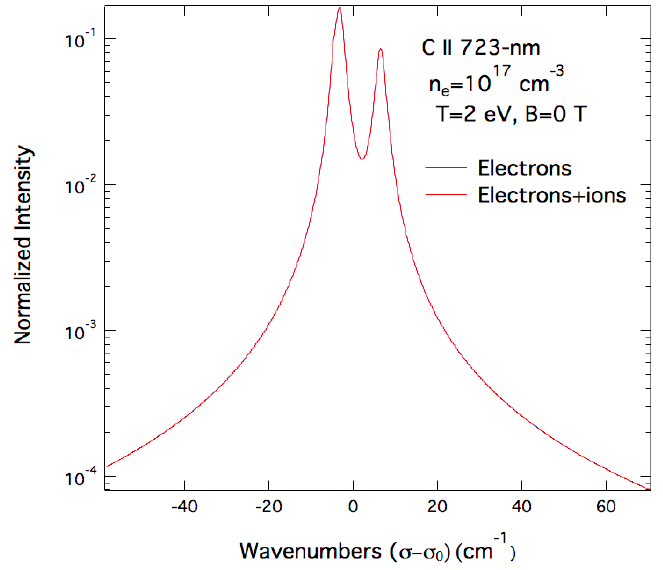
Figure 3. Comparison of Stark profiles of the C II 723-nm line emitted by a pure carbon plasma (electrons and C + ions) computed with the following parameters: n = T = 2 eV and B = 0. Dashed line represents the electron broadening only while the T e i solid one accounts for both ions and electrons, all other broadening mechanisms were ignored. Note the use of a semi-logarithmic scale. Both profiles were calculated using PPP-B with atomic data from NIST and by setting B = 0